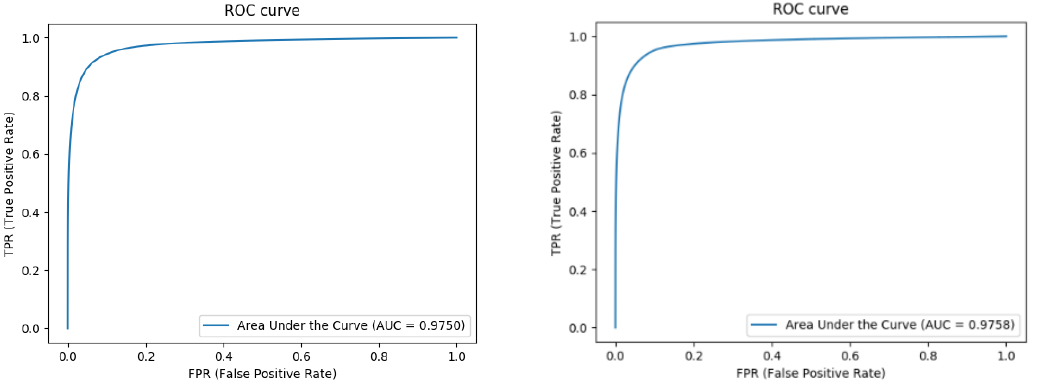
Figure 6. ROC curves of our model. On the left is the ROC curve for the DRIVE dataset and the ROC curve for the STARE on the